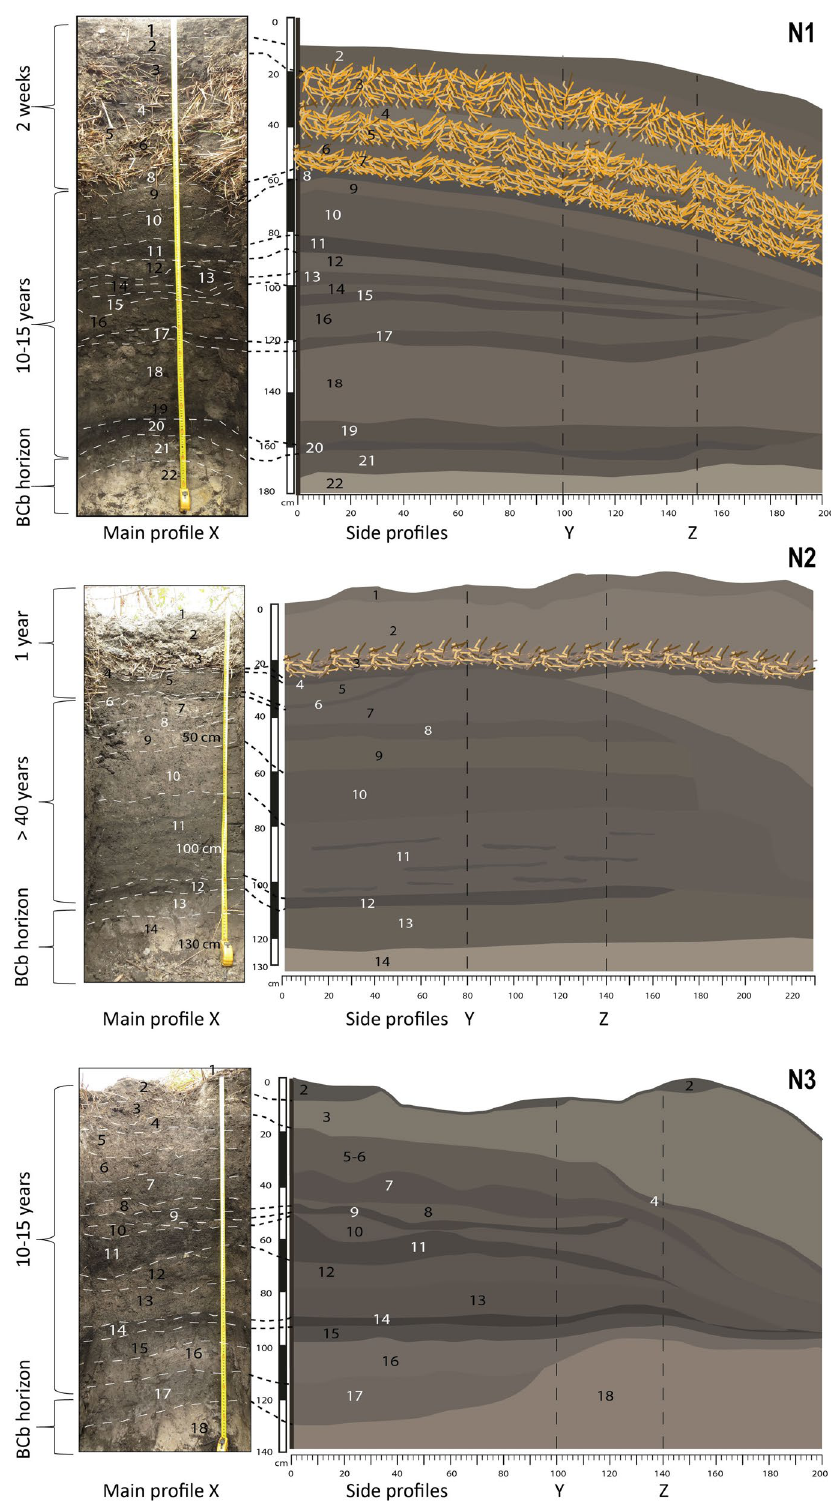
Figure 3. Age and internal morphology of RFs N1–N3. Layers are labeled with numbers. Left panel for each field presents the main profile (X), right panel the two side profiles (Y and Z). Note: layer 1 in side profiles of RF N3 is missing. It was unintentionally removed during our observation and sampling campaign when the field was cleared of fallow vegetation before excavation of the trench. Photos (1–20 August 2017), Leonor Rodrigues and Tobias Sprafke. (Ilustrations made with Adobe